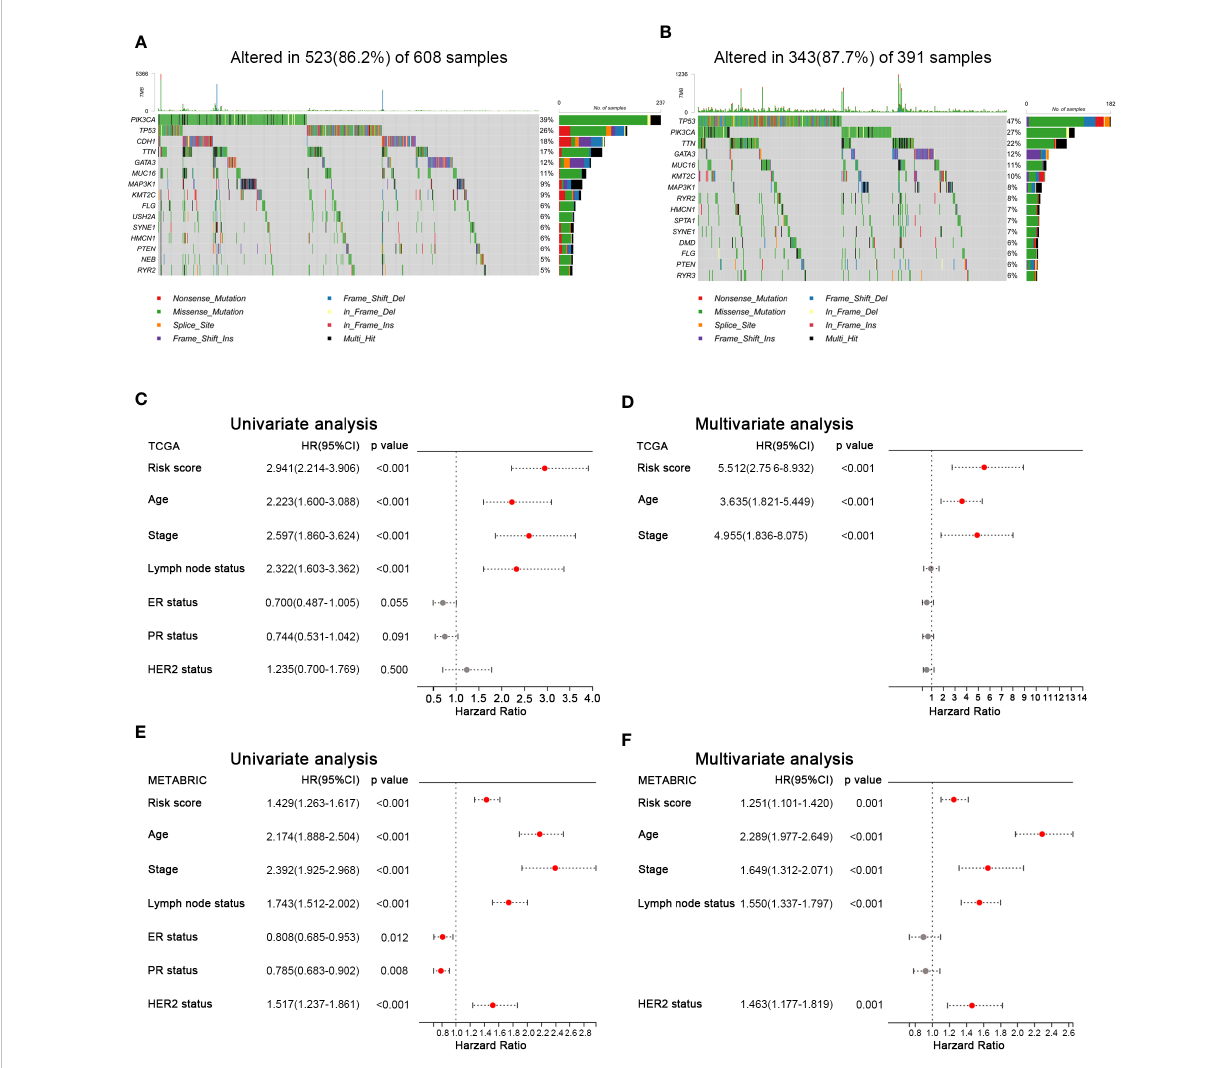
FIGURE 7 Mutation landscape and prognostic factors of BC patients. (A, B) Oncoplots show the mutated genes in the high-HFRS (A) and low-HFRS (B) groups of the TCGA cohort. (C) Forrest plots of univariate and multivariate analyses show the independent prognostic predictors in the TCGA and METABRIC